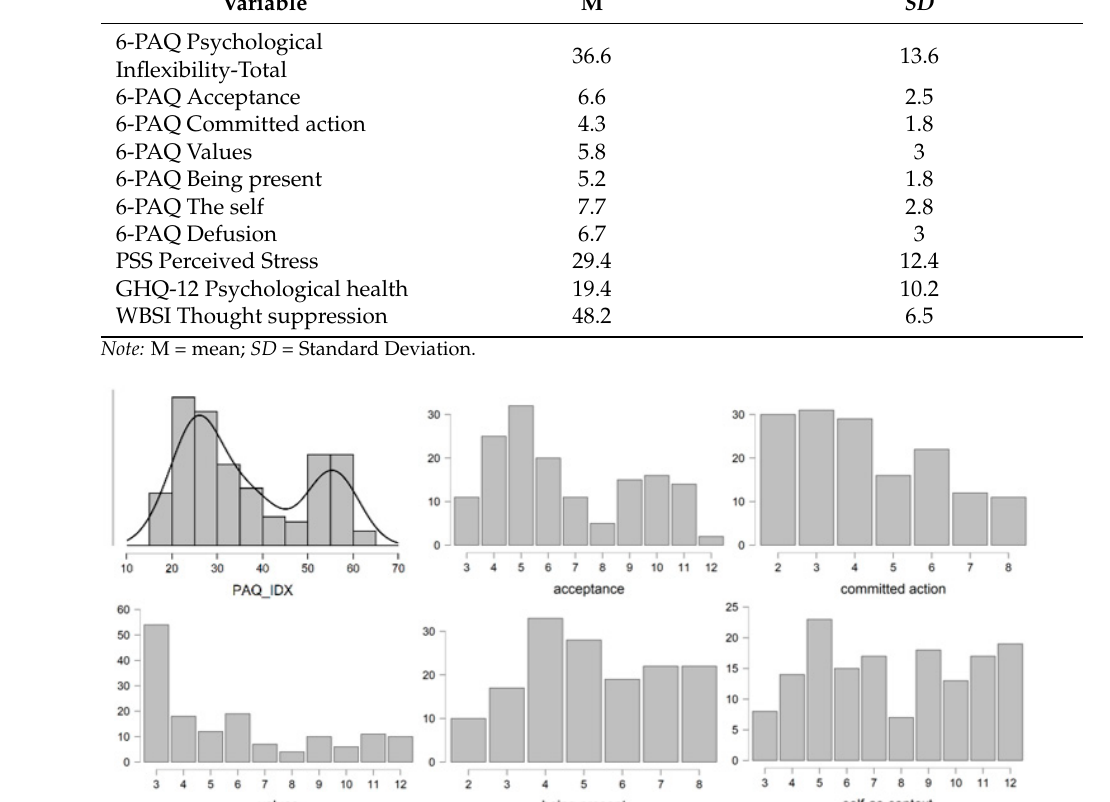
Figure 2. Distribution of the scores of 6-PAQ and its subscales. Note: GHQ_IDX: GHQ total score; PSS_IDX: PSS total score; WBSI_IDX: WBSI total score.